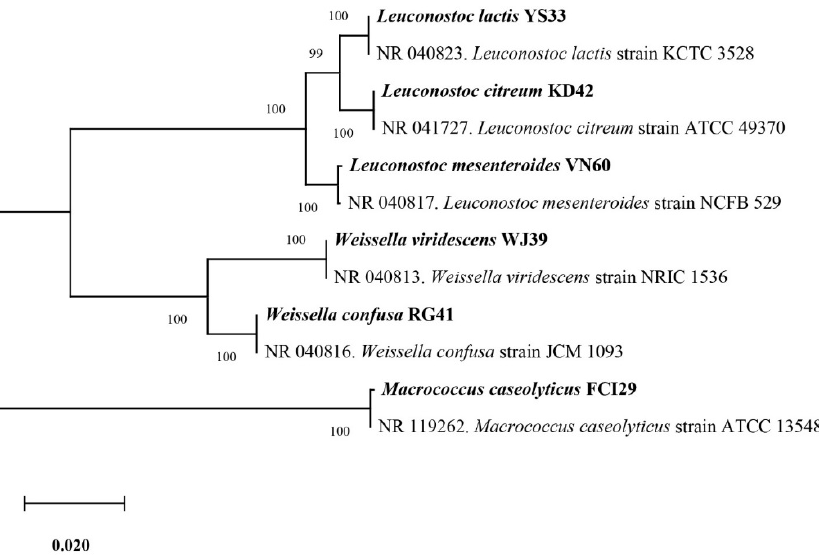
Figure 3. Phylogenetic tree based on the sequencing results of the 16S rRNA gene shows the relationships between all six isolated bacteria.